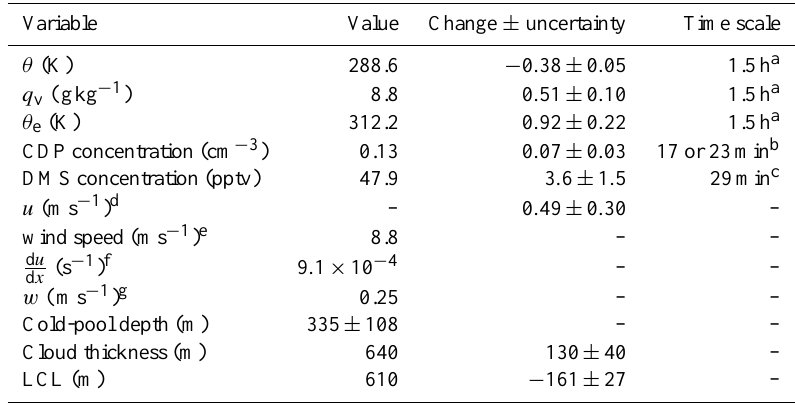
a Estimated time scale necessary to reach observed differences in cold pools, calculated from simple box model differences driven by surface sensible and latent heat fluxes (see Sect. 4.4). d Denotes wind speed along the direction of flight (see Sect 4.2). The 4/ π correction is not applied to the change. e In situ horizontal wind speed measured at flight altitude ( ∼ 150 m ). f Mean composite value at the cold-pool edge at flight altitude ( ∼ 150 m ). The 4/ π correction is not applied to the